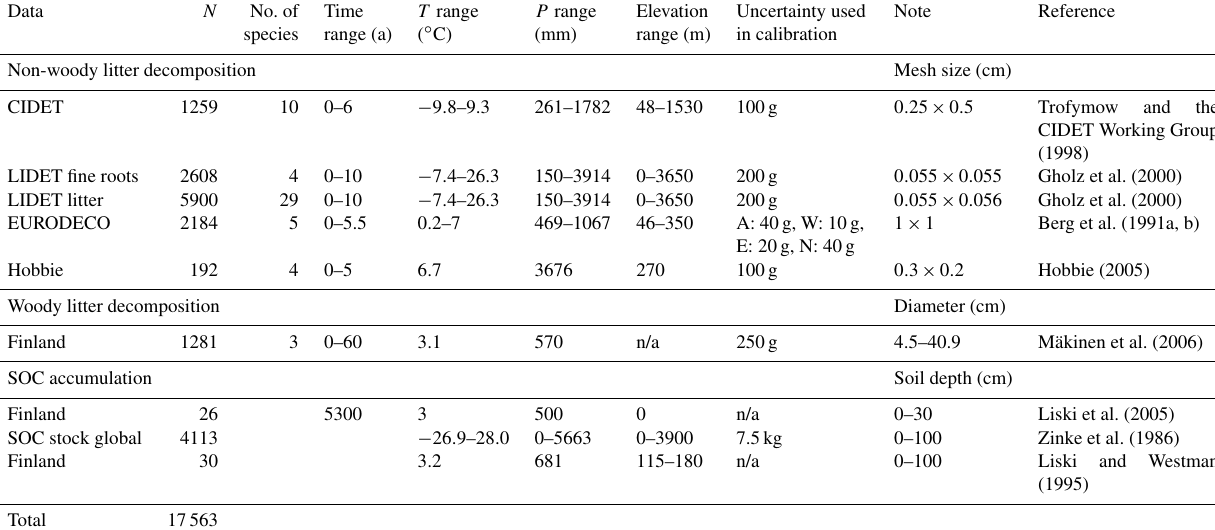
Table 2. The measurement datasets used in this research. Data N No. of Time T range P range Elevation Uncertainty used Note Reference species range (a) ( ◦ C) (mm) range (m) in